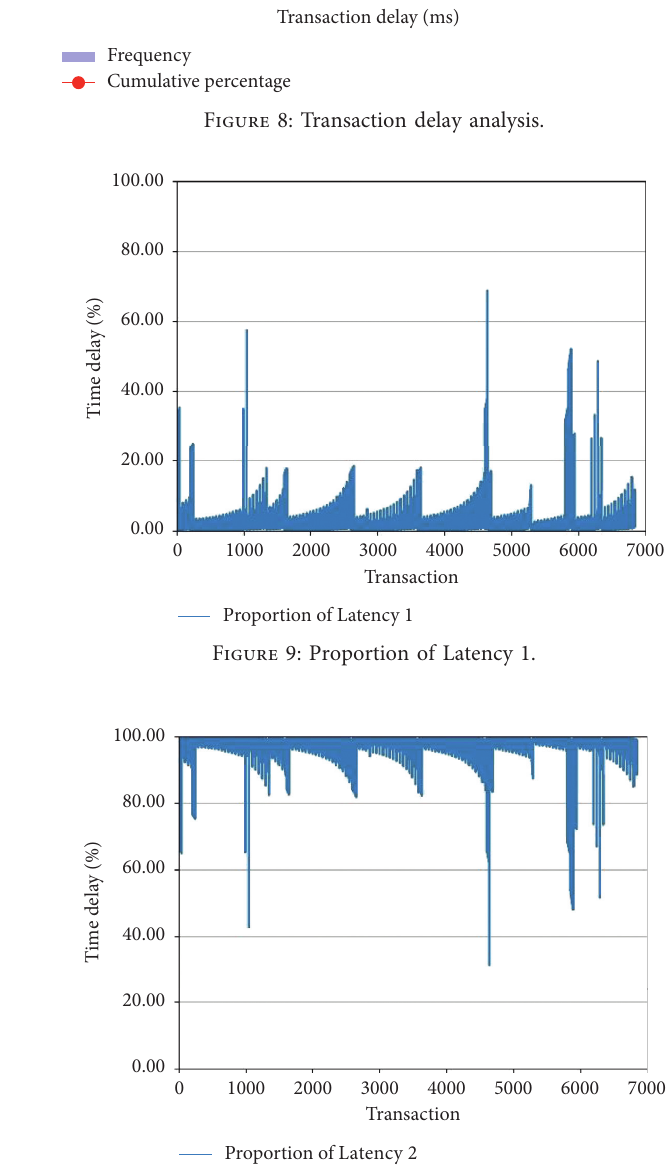
Figure 10: Proportion of Latency